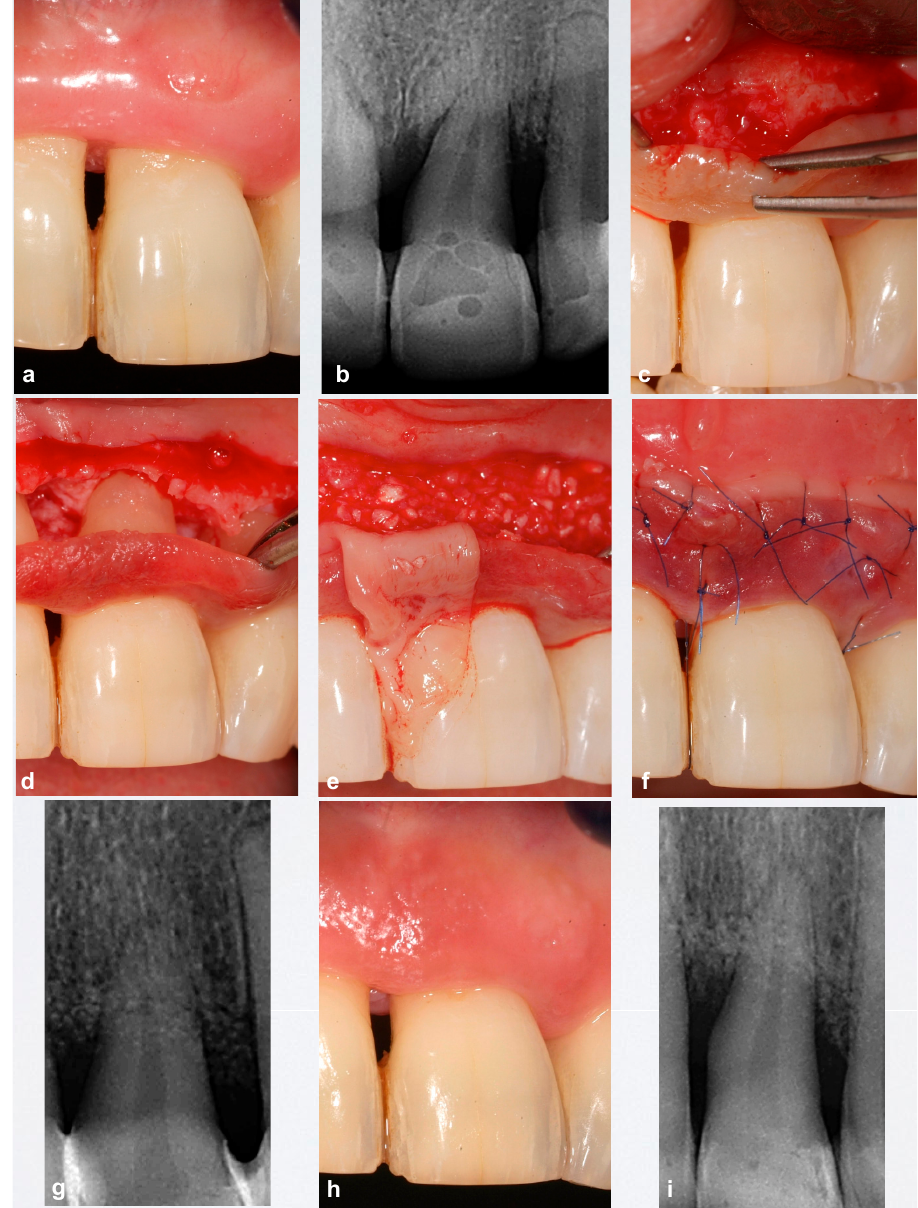
Figure 2. Case 21. ( a , b ) Upper left central incisor with advanced periodontal destruction and grade II mobility with two mesial and distal intra-bone defects. ( c , d ) Apical incision exposing intrabony defects and lack of vestibular cortical plate. ( e ) Biomaterials and adapted L-PRF membrane. ( f , g ) Suture and post-surgical X-ray. ( h , i ) Clinical view and X-ray 12 months after surgery. We applied 24% ethylene diamine tetra-acetic acid gel (PrefGel, Straumann ® , Basel,